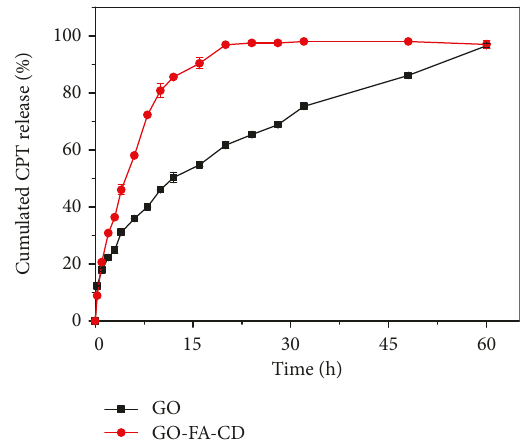
Figure 7: Cumulated CPT release for drug-loaded GO and GO-FA-CD nanocarrier in PBS at 37 °